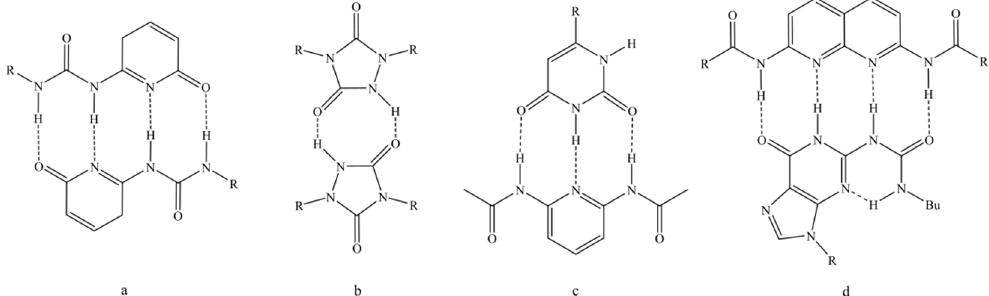
Figure 1. Well investigated examples for different multiple hydrogen bonding motifs. Self-complementary groups as ( a ) 2-ureido-4[1H]-pyrimidinone group (UPy) [10], ( b ) motifs with urazole units [13], ( c , d ) non-self-complementary groups with uracil and 2,6-diacyl-amino-pyridin type motifs [17] and deazapterin combined with UPy [18], respectively.